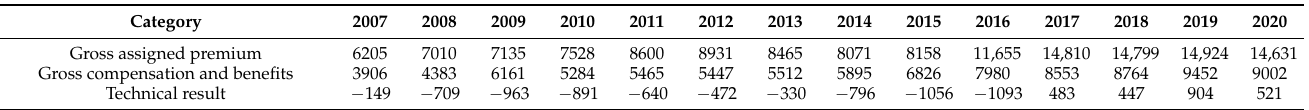
Table 2. Technical results of the MTPL market in Poland between 2007 and 2020 (PLN million; UKNF 2021).